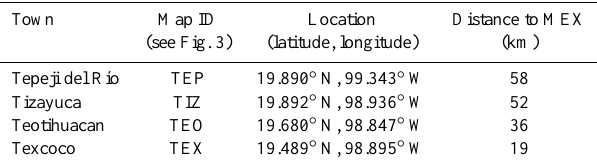
Table 1. MCMA CMET balloon launch sites during the MILAGRO campaign. The Texcoco site was approved only for a single launch. The distance listed in the far right column is measured from the MEX airport near the center of Mexico City.